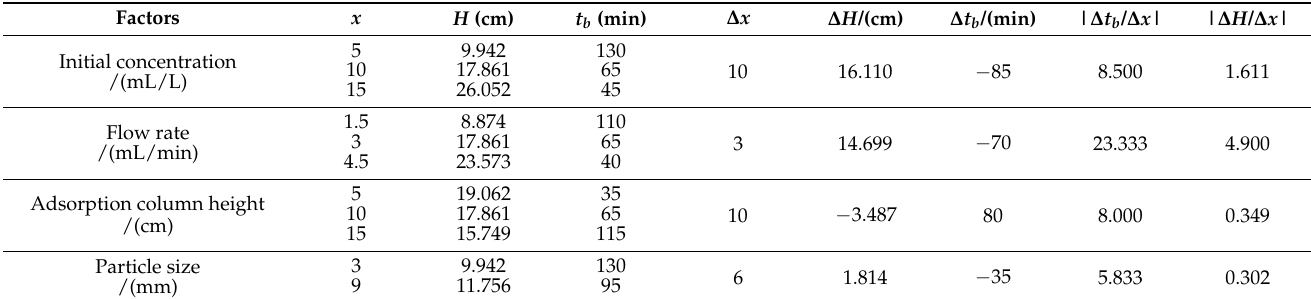
Table 4. Effects of different conditions on the breakthrough curve.